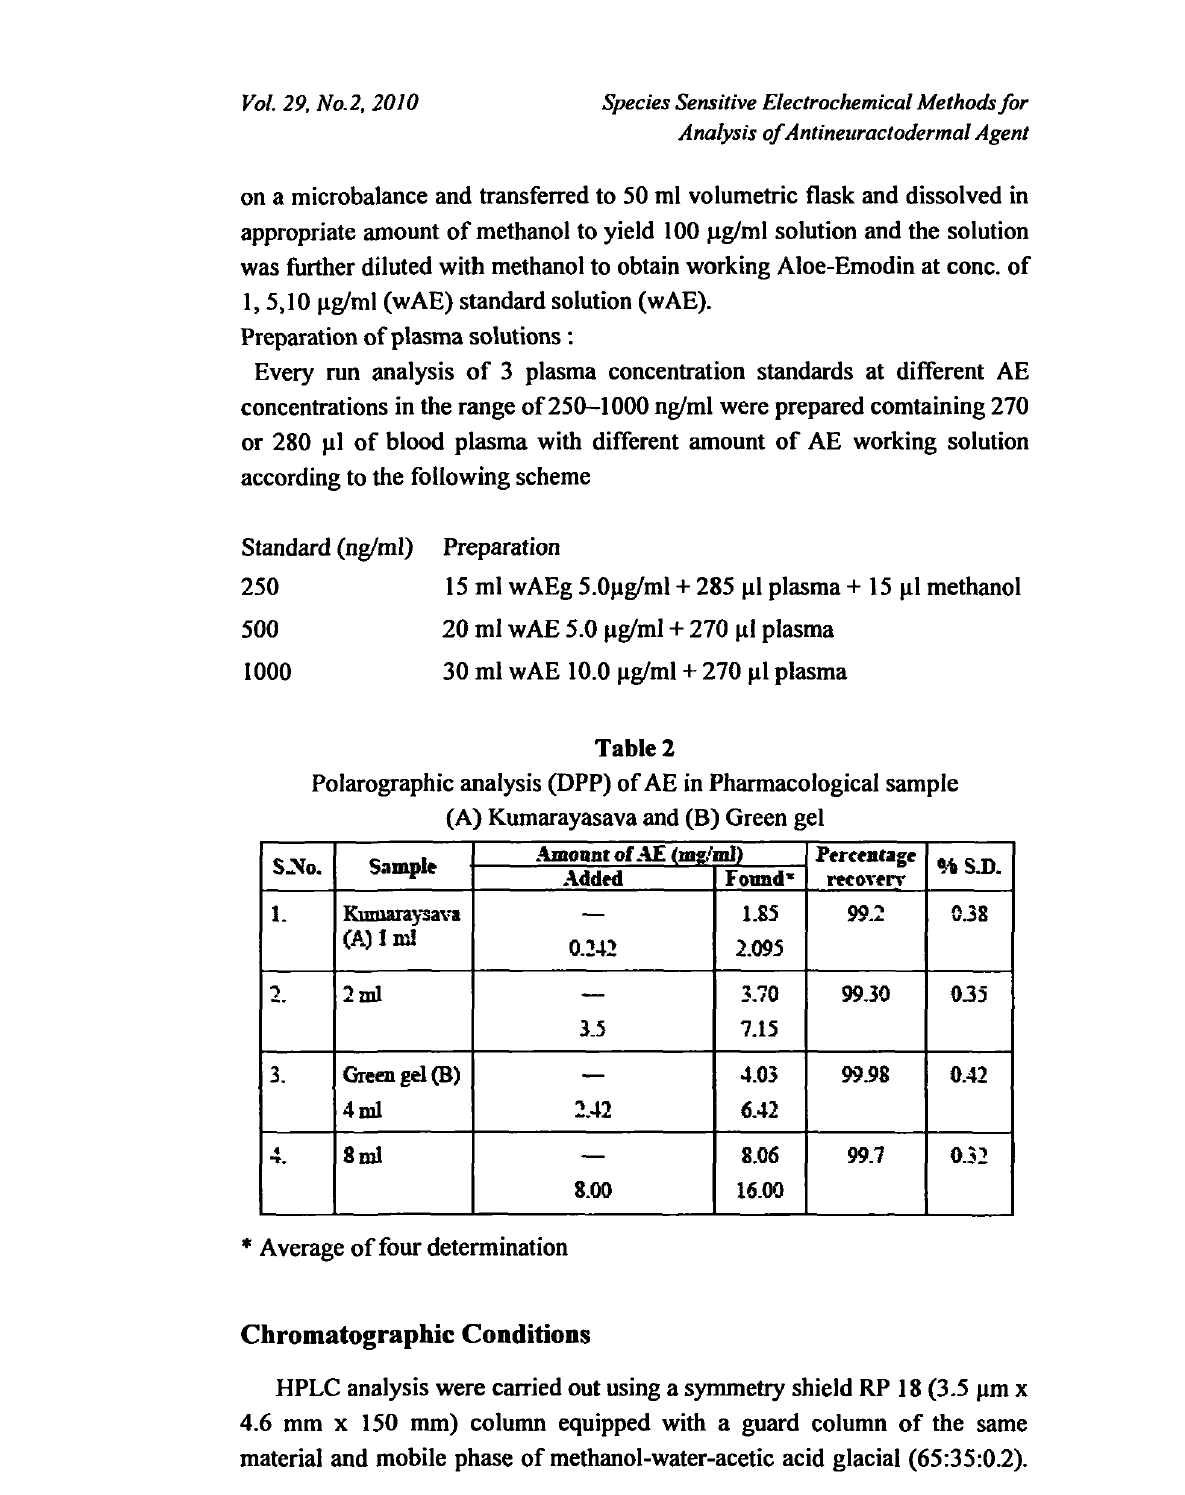
Polarographic analysis (DPP) of AE in Pharmacological